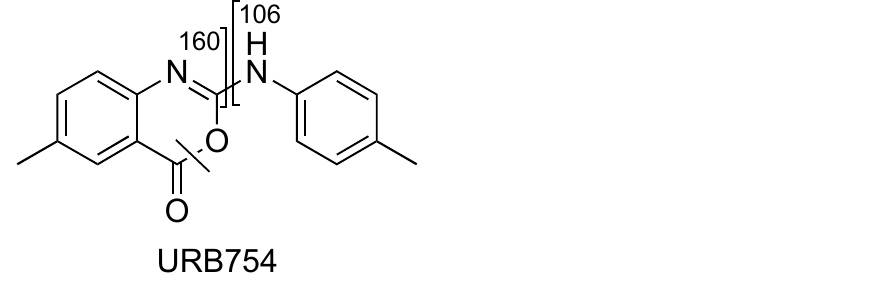
Figure 14. Representation of the collisional-induced fragment ions of URB754 compound.